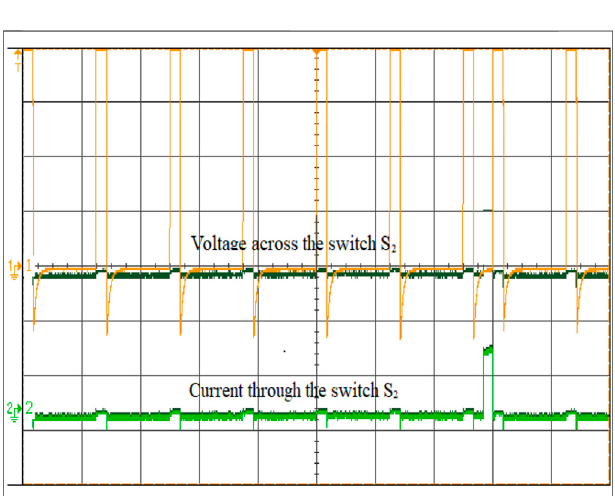
FIGURE 12 | Current through the coil I L1